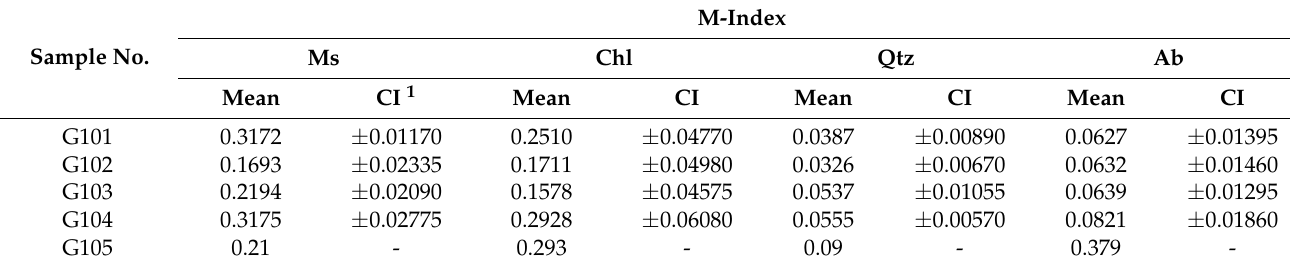
Table 2. Fabric strength of minerals in phyllite